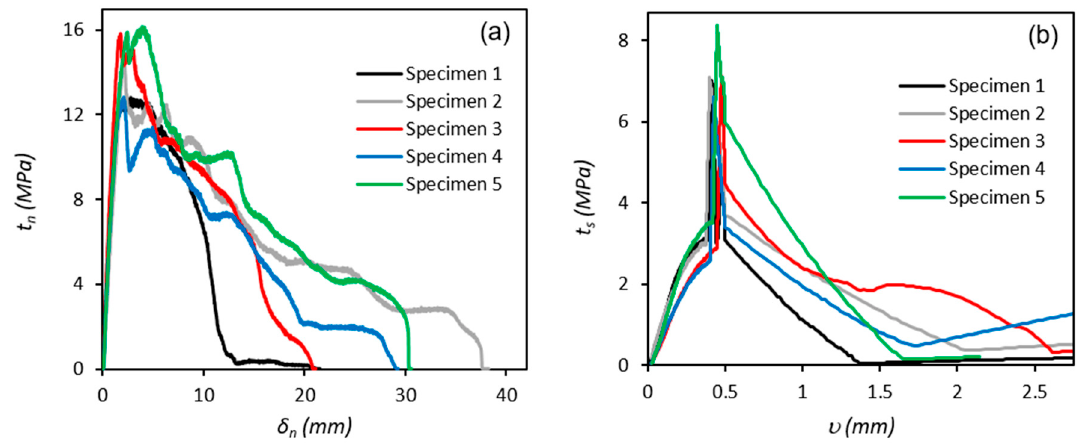
Figure 8. Cohesive strength curves for ( a ) DCB and ( b ) ENF tests.